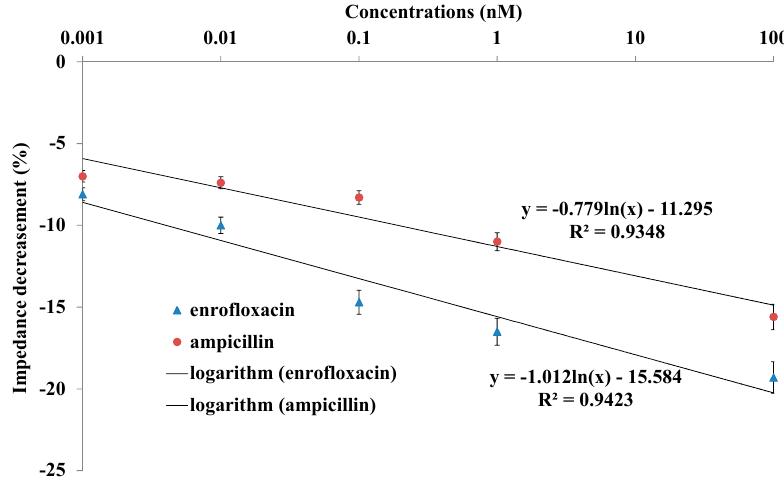
Figure 6. The impedance change of nanoporous alumina membrane with GQDs with different concentrations of enrofloxacin and ampicillin at incubation time of 10 min.